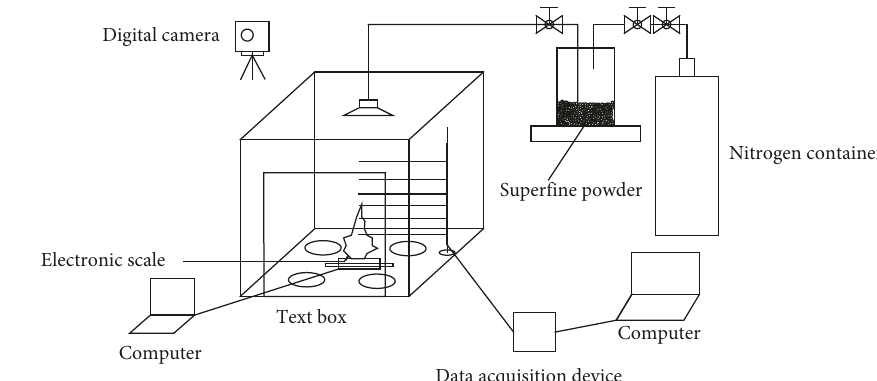
Figure 1: Schematic of the extinguishing